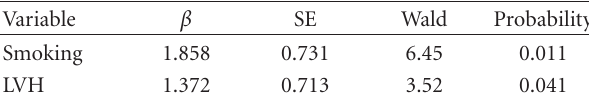
Table 3: Cox hazard stepwise regression analysis for